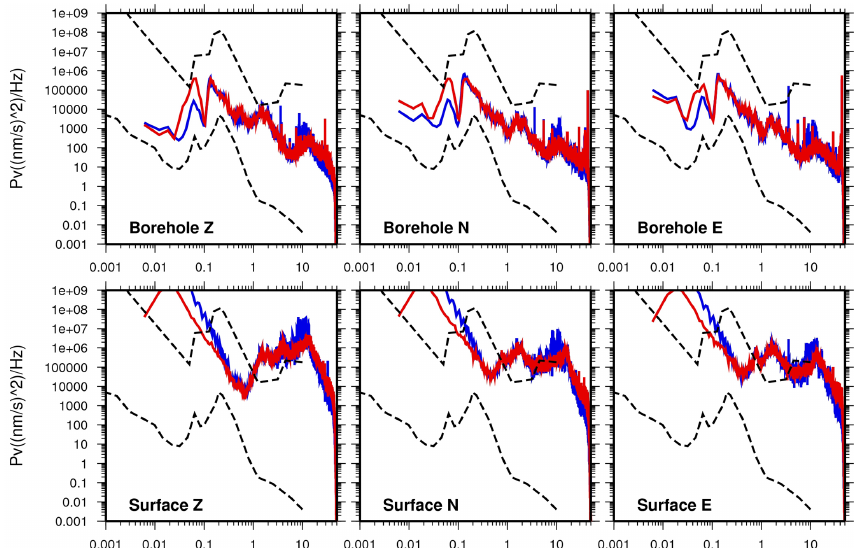
Figure 4. Power Spectral Density (PSD) of ground noise recorded at the bottom (top panels, divided by components) and at the surface (bottom panels, divided by components) compared with the Peterson New Model limits of noise (black dashed lines). Daytime (red lines) and nighttime (blue lines) are plotted for each component. Data noise are the same at top and bottom, and a reduction at the bottom site is evident.